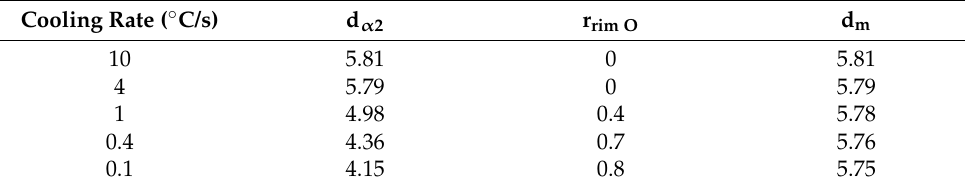
Figure 11. ( a ) {0001} and <11 2̅ 0> pole figures of the purple α 2 phase, ( b ) {001} and <110> pole figures of the green rim O phase. Table 2. d α2 (μm) under different cooling rates. d α2 is the diameter of the α 2 particles, r rim O is the thickness of precipitated rim O and d m is the diameter of the (O + α 2 ) particles.